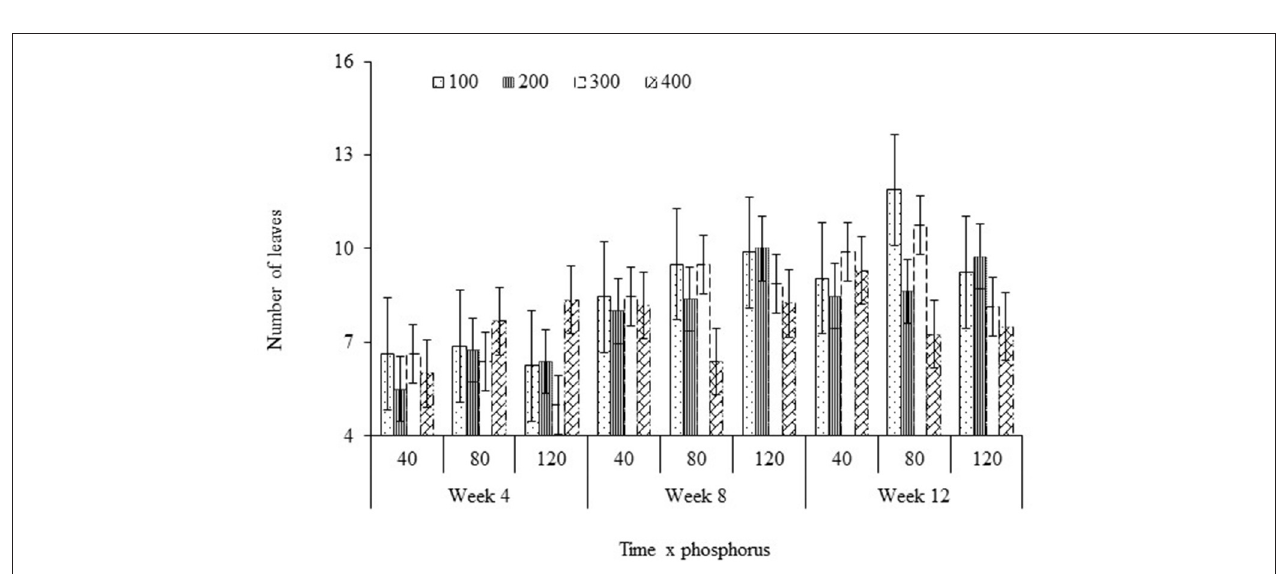
FIGURE 4 | Effects of time, phosphorus and nitrogen fertilizer on the number of leaves of moringa trees. Error bars indicate standard